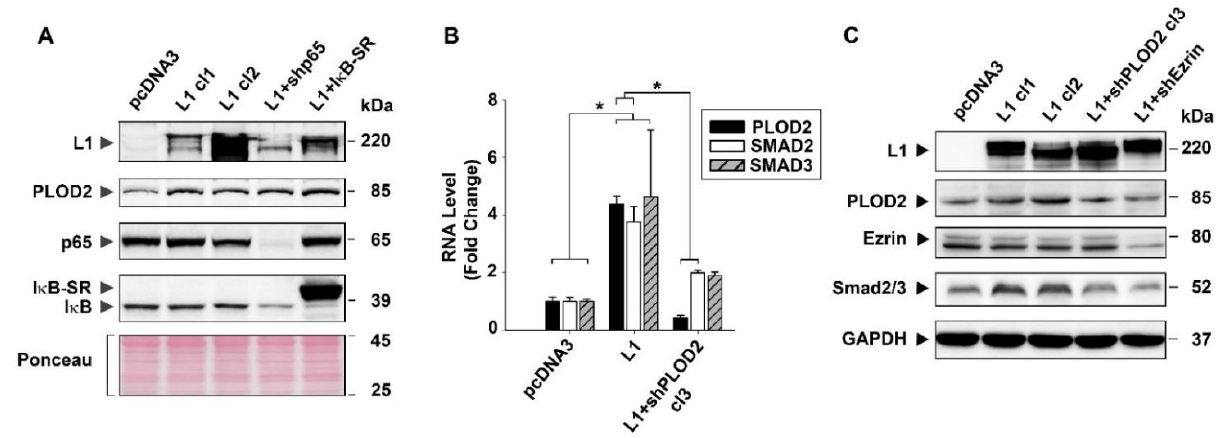
Figure 5. The induction in PLOD2 levels conferred by L1 transfection correlates with an increase in SMAD2/3 expression, but it is not affected by NF- κ B signaling. ( A ) The levels of PLOD2 were determined in CRC cell clones expressing the control pcDNA3 plasmid, L1 (L1 cl1 and 2), L1 and an shRNA to the p65 NF- κ B subunit (L1 + shp65) or L1 and a super-repressor of NF- κ B signaling (L1 + I κ B-SR). The levels of PLOD2, L1, p65 and I κ B were determined by Western blotting with the relevant antibodies. Ponceau staining of the blots was used to determine equal protein loading. ( B ) RNA levels for PLOD2, SMAD2 and SMAD3 were determined by RT-PCR using the CRC cells stably expressing the control pcDNA3 plasmid, L1 and L1 + shRNA to PLOD2. ( C ) Western blot analysis of the levels of PLOD2, SMAD2/3 and ezrin in the CRC cell clones expressing the control pcDNA3 plasmid, L1 (L1 cl1 and cl2), L1 + shPLOD2 and L1 + shEzrin. GAPDH levels served to determine equal protein loading on the gel. Note the correlation between the changes in the levels of PLOD2 and SMAD2/3 in the different CRC cell clones. * p < 0.05.